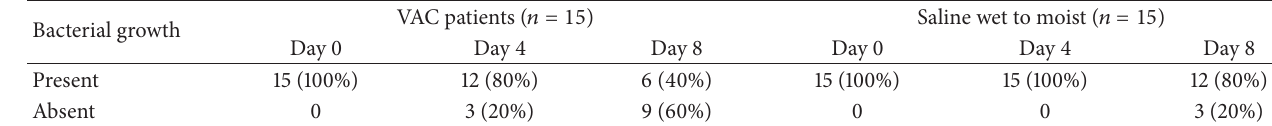
Table 3: Bacterial growth ( 𝑛 = 30 ).